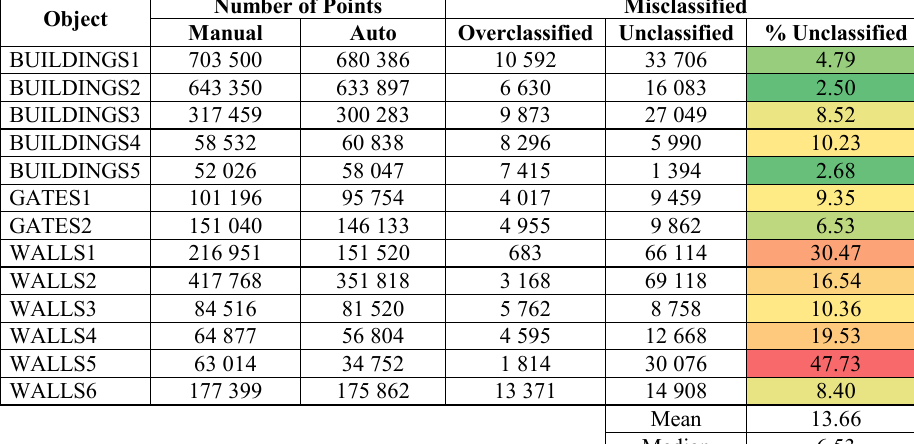
Table 1. Segmentation statistics for the 13 object clusters of interest (trees are not included). Results show that the developed approach was successful in segmenting the Siti Inggil area and annotating each segmented portion with the relevant semantic information, even by using roughly digitised shapefiles (centimetric precision). The results for the first use of the algorithm on the walls class is shown in Figure 4. Most of the walls were segmented correctly, except for the object WALLS5 where a large part of it was considered by the algorithm as another object altogether. This may have been due to the low resolution of the TLS on this particular part of the wall, as the critical junction that caused the segmenting failure is found behind a tree. Only two objects are present within the gates class (Figure 5), and the algorithm seems to have been able to perform the segmentation correctly. Five buildings are included in the buildings class (Figure 6), all of which were segmented properly. BUILDINGS4 and 5 showed a small portion of ground point cloud still included in their respective clusters; this is due to the parameterising of the CSF algorithm. In general, smaller buildings yielded slightly worse result in the CSF ground classification, as seen here in the